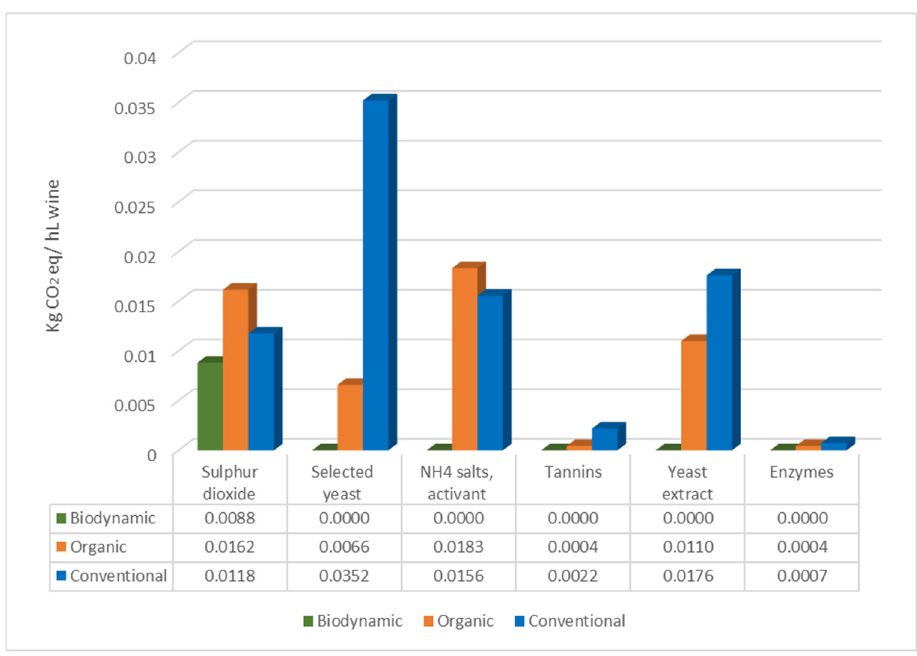
Figure 1. Estimated carbon dioxide emission expressed as kg of CO 2 eq/hL of wine for biodynamic, organic, and conventional wineries based on the survey data (average values).